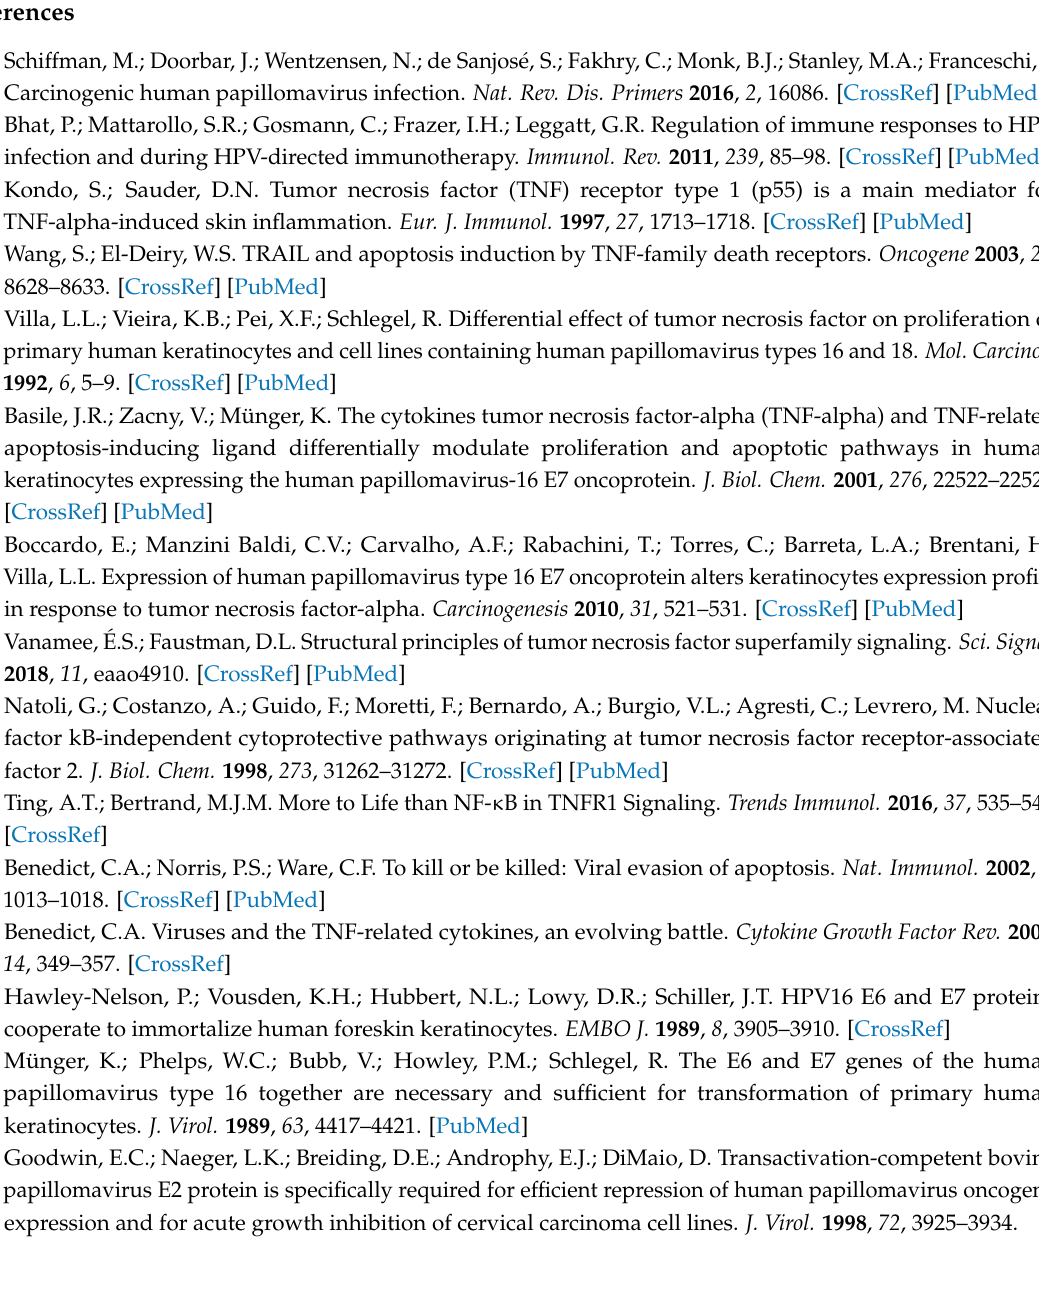
Figure S1. Cervical cancer-derived cell lines are resistant to TRAIL; Figure S2. Cervical cancer-derived cell lines are resistant to the combined action of pro-inflammatory cytokines TNF and TRAIL; Figure S3. Effect of HPV16 E6 and E7 in the levels of proteins associated with apoptosis regulation/execution upon treatment with TNF; Figure S4. Effect of HPV11 E6 and E7 in the levels of proteins associated with apoptosis regulation/execution upon treatment with